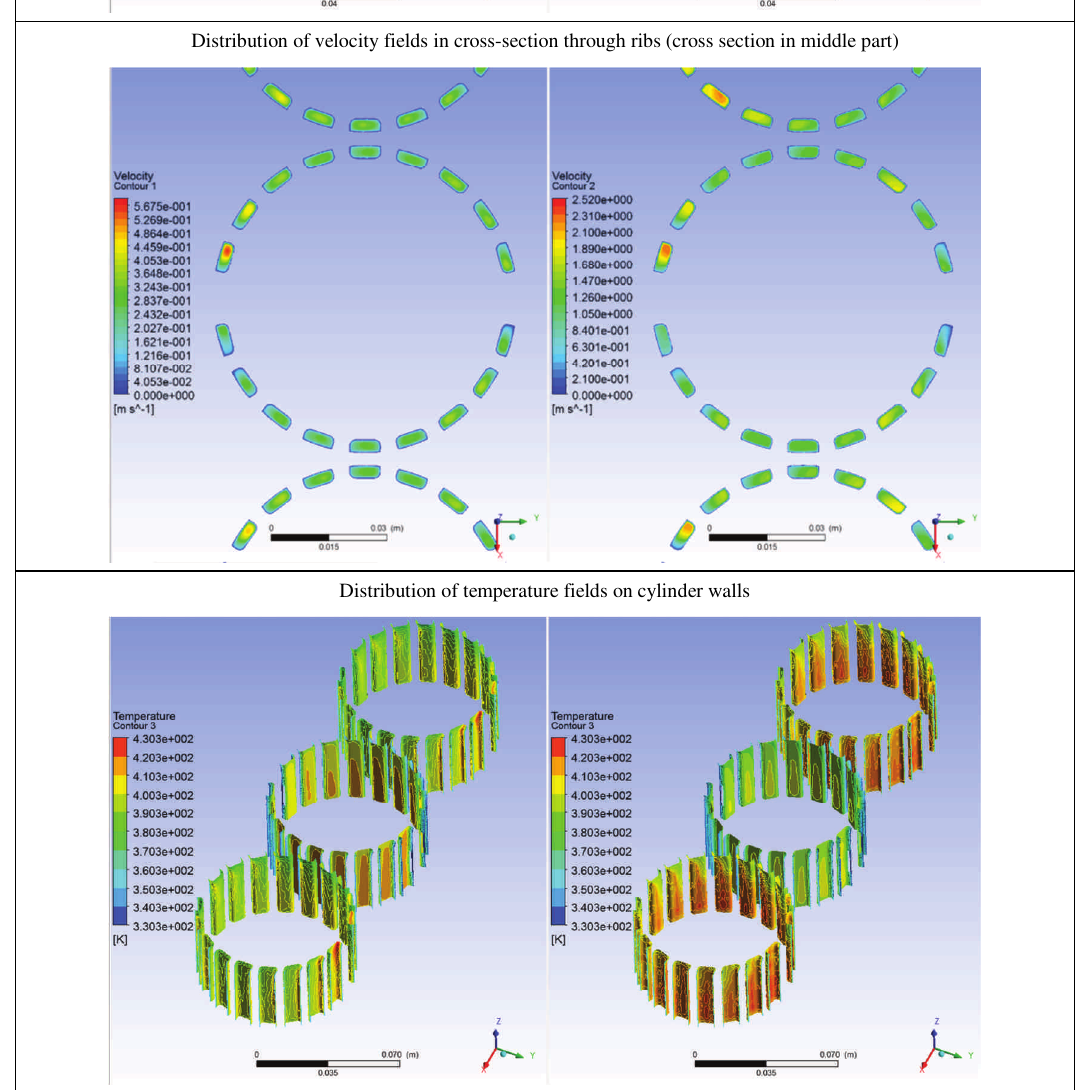
Fig. 17. Comparison of distribution of velocity fields across the ribs and temperature fields for the final model, for two mass flow